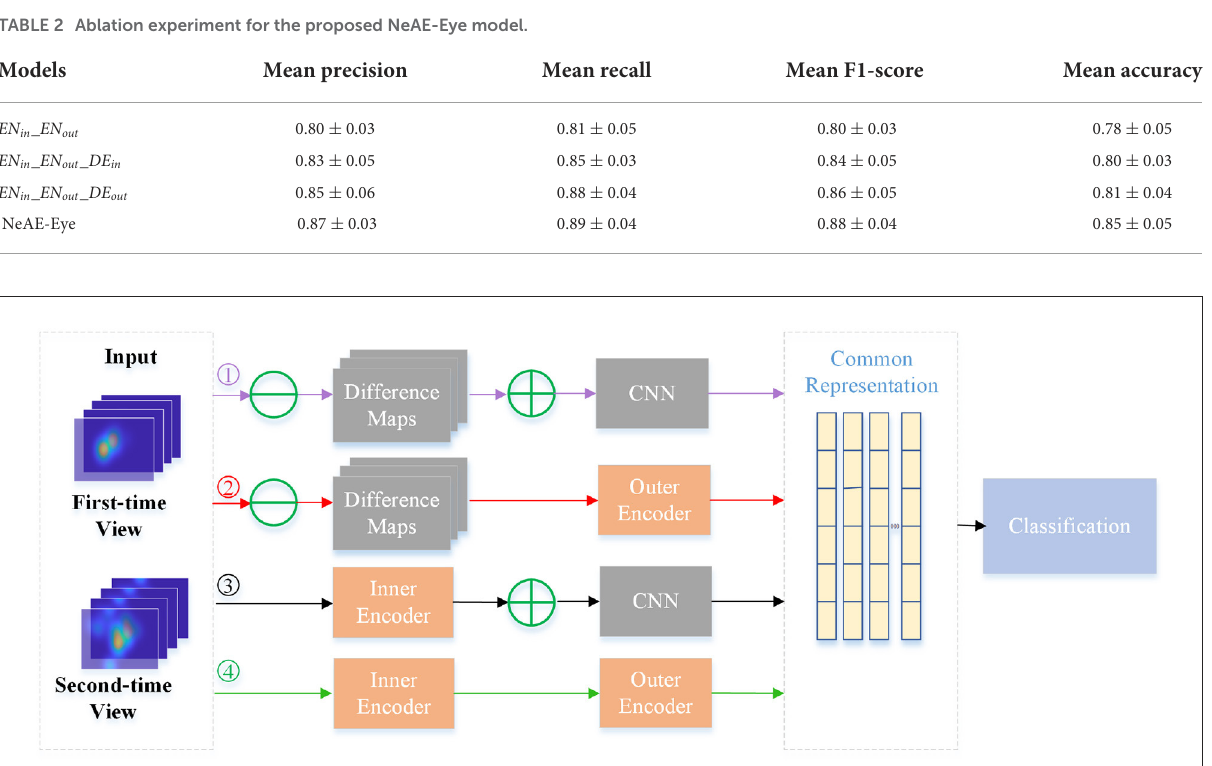
region preference features and novelty preference